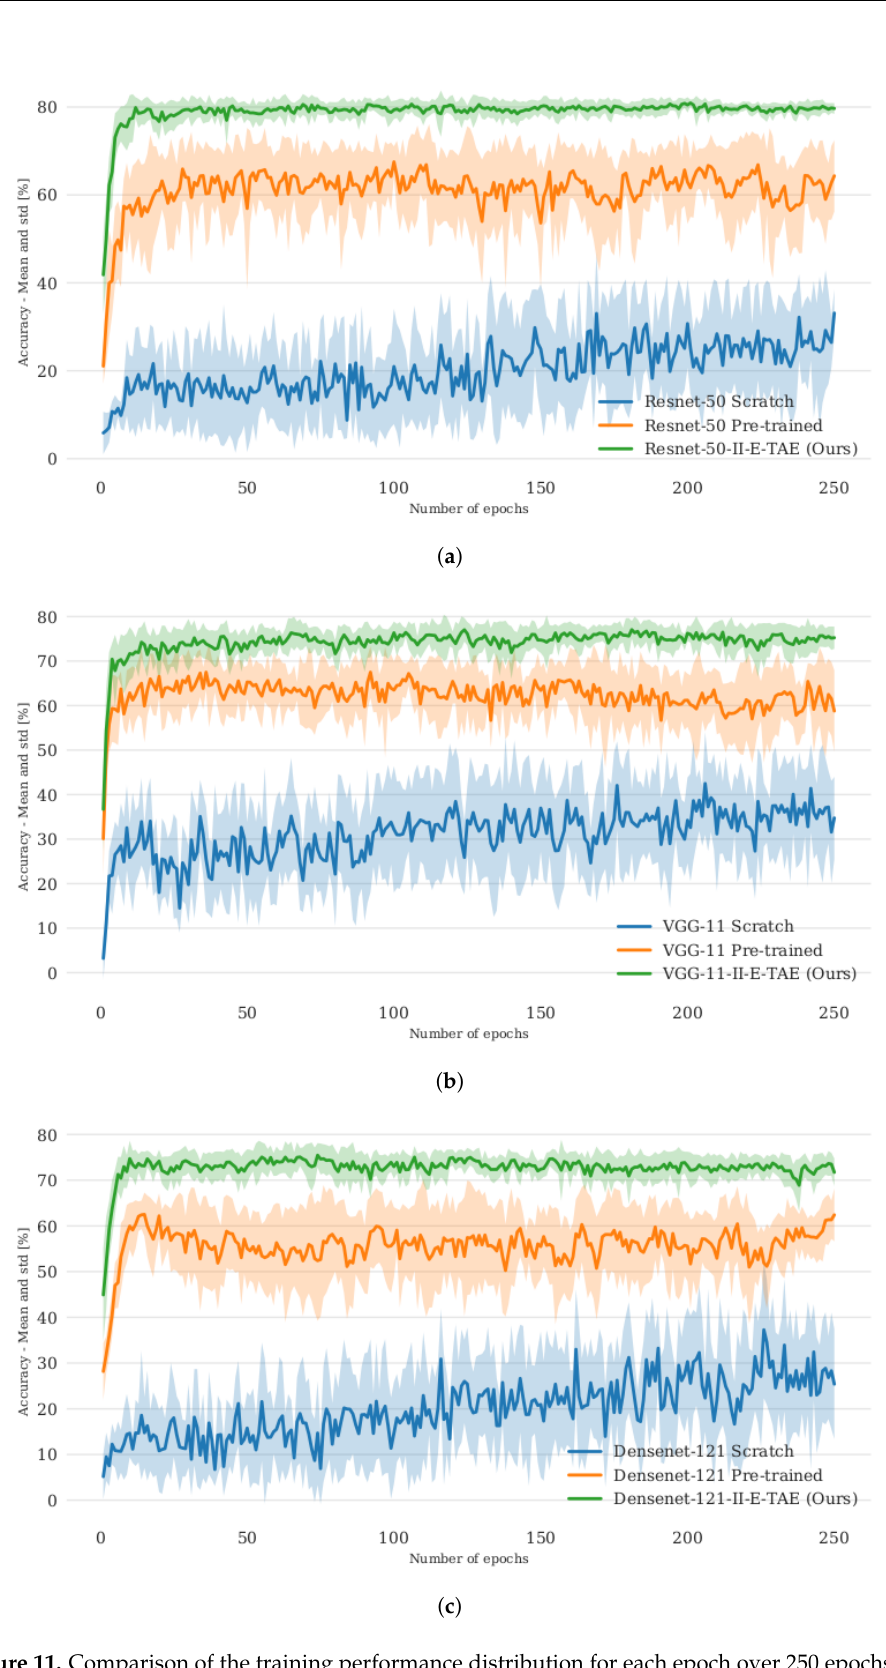
Figure 11. Comparison of the training performance distribution for each epoch over 250 epochs. II-E- TAE (extractor triplet autoencoder using the II-PIRL) is compared against training the extractor from scratch or fine-tuning the layers after the features used by the extractor in our approach. ( a ) Resnet-50. ( b ) VGG-11. ( c )